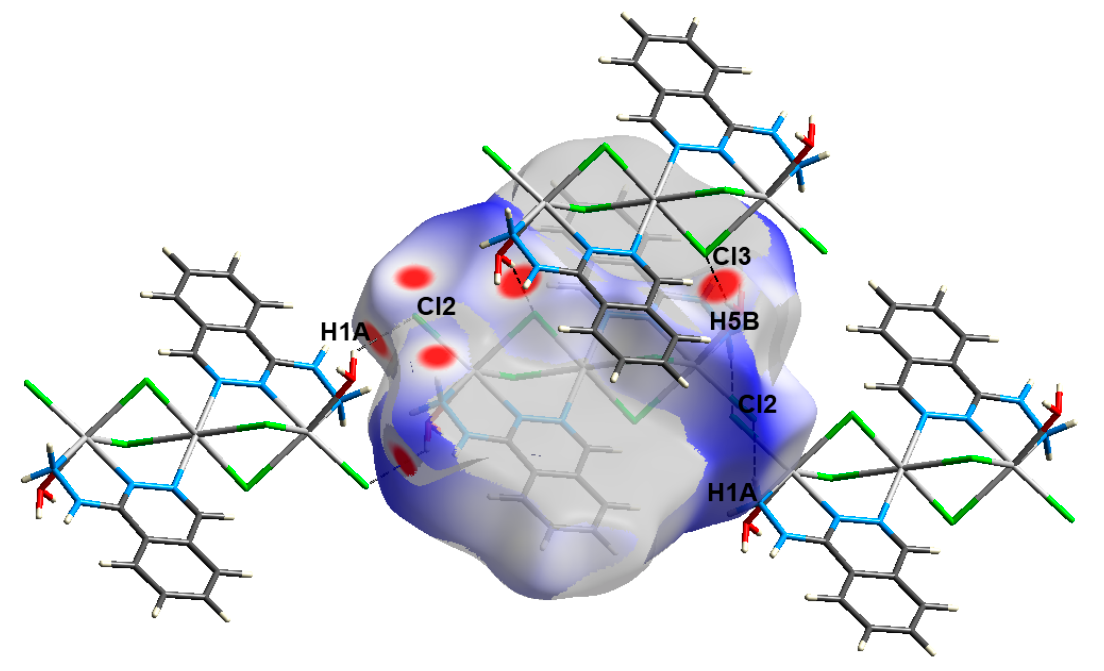
Figure 15. The Hirshfeld surface showing the molecular packing diagram showing the Cl...H hydrogen bonds in complex 3 .